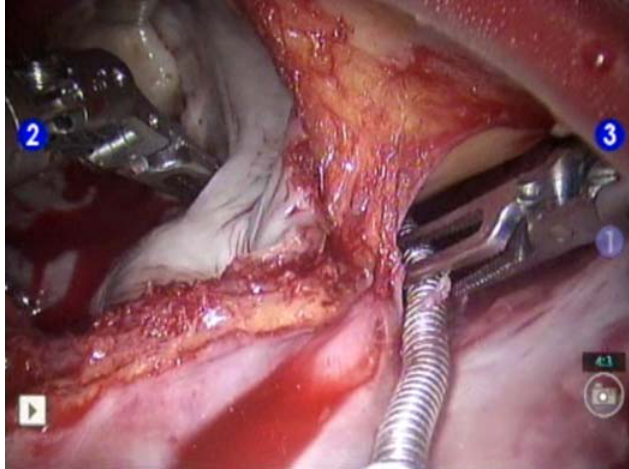
Figure 7. Epicardial lesion over the coronary sinus placed with the probe in the oblique coronary